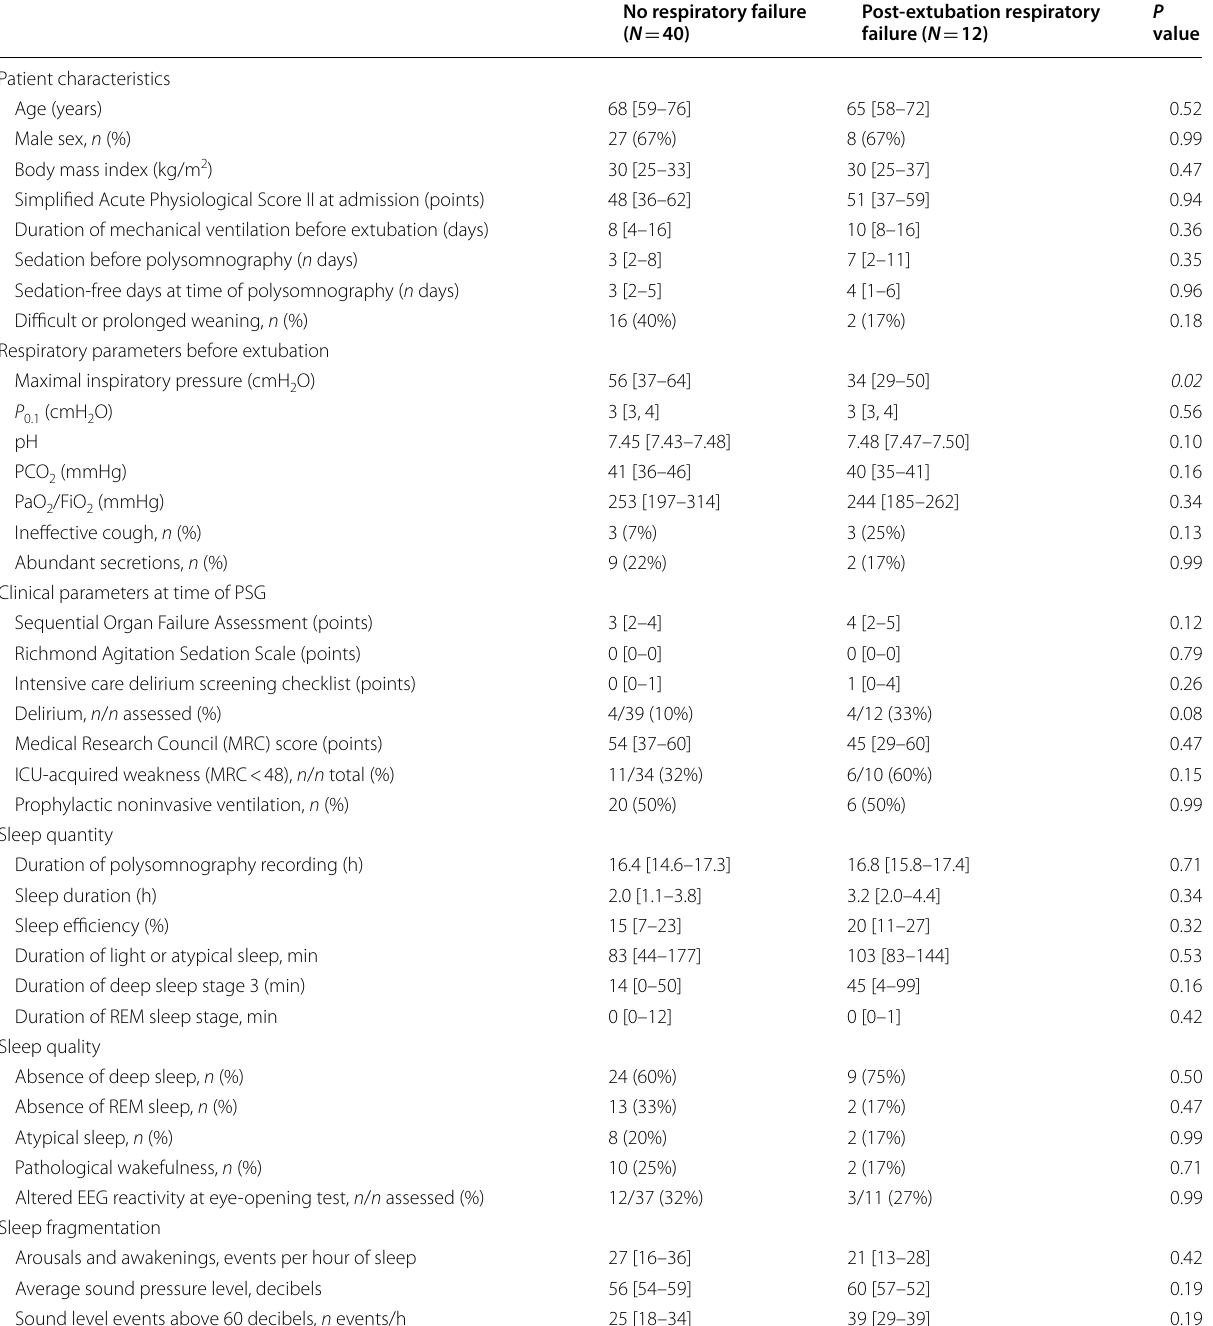
Table 3 Comparison of patients who developed post‑extubation respiratory failure and those who succeeded extubation with no respiratory